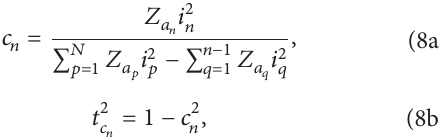
the couplers, 𝛼 𝑠 = 𝑘𝑑 sin 𝜃 𝑠 cos 𝜙 𝑠 is the interelement phase to scan the antenna beam along 𝑥 -axis at ( 𝜃 𝑠 , 𝜙 𝑠 ), and 𝑡 𝑝 transmission coefficient of the